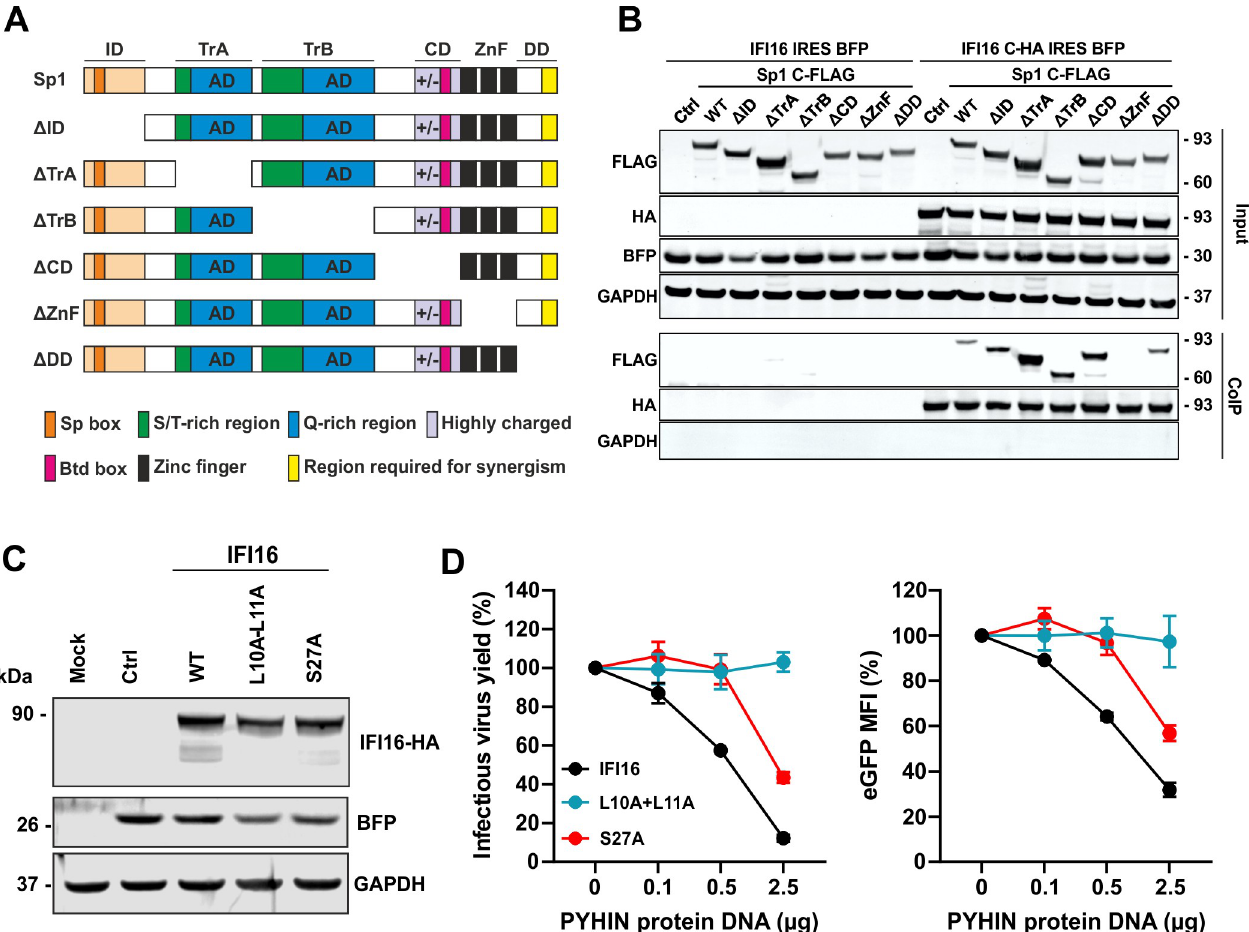
Fig 9. Determinants of Sp1-IFI16 interaction and antiviral activity. (A) Schematic overview on mutants Sp1 proteins generated and examined. ID: inhibitory domain; TrA: transactivator domain A; TrB: transactivator domain B; CD: C domain; ZnF: Zinc-fingers; DD:D domain. (B) HEK293T cells were cotransfected with expression constructs for the indicated FLAG-tagged mutant Sp1 proteins and HA-tagged IFI16 or a vector control. At 40 h post- transfection, cells were lysed and IFI16 was immunoprecipitated using anti-HA antibodies and protein A/G magnetic beads. Proteins were blotted and stained using anti-FLAG, anti-HA, anti-BFP and anti-GAPDH antibodies. The upper panels show representative western blots and the lower panels the results of the Co-IP. Results show one representative experiment of three performed. (C) Expression of WT and mutant IFI16 proteins. HEK293T cells were transfected with IRES-BFP constructs expressing the indicated HA-tagged IFI16 proteins. BFP and GAPDH were used as controls. (D) HEK293T cells were cotransfected with a control vector or expression constructs for the indicated IFI16 proteins expressing BFP via an IRES together with a proviral NL4-3-IRES-eGFP construct. Two days later infectious virus yield was quantified by TZM-bl cells infection assay (left) and BFP and eGFP MFI were measured by flow cytometry (right). Mean fluorescence intensity (MFI) of eGFP in the BFP positive population is shown. Shown are mean values ( ± SD) from four replicates.